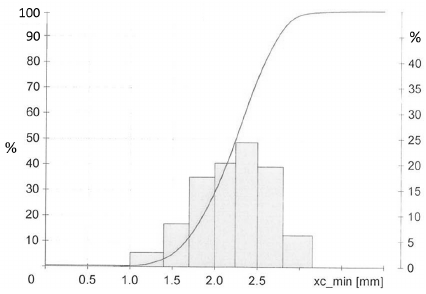
Figure 12. Size distribution of GTR